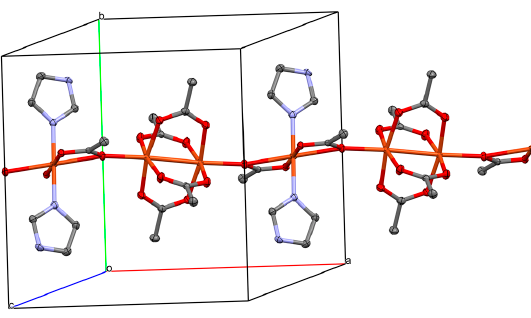
Figure 3. Extended representation of 1 with 50% displacement ellipsoids; H-atoms omitted for clarity. Interchain hydrogen bonding is observed between the Cu2-bonded donor imidazoles to one of the monomer acetate oxygen atoms (H2 … O6 1.93(2) Å; N2-H2 … O6 176(2)°; Figure 4.) The overall effect is that each Cu2 is involved in short outersphere interactions with four symmetry-related Cu2 moieties, each part of a different chain.